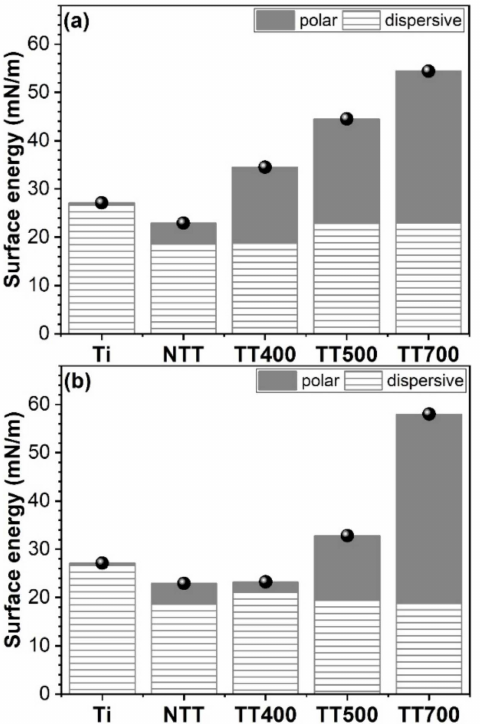
Figure 16. The surface free energy values recorded for the control (Ti), NTT LiP and for those subjected to post-deposition thermal treatments (at different temperatures), in air ( a ) and water-vapor ( b )